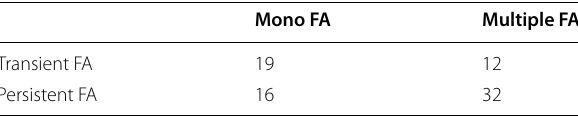
Table 2 Allergy group status compared to number of